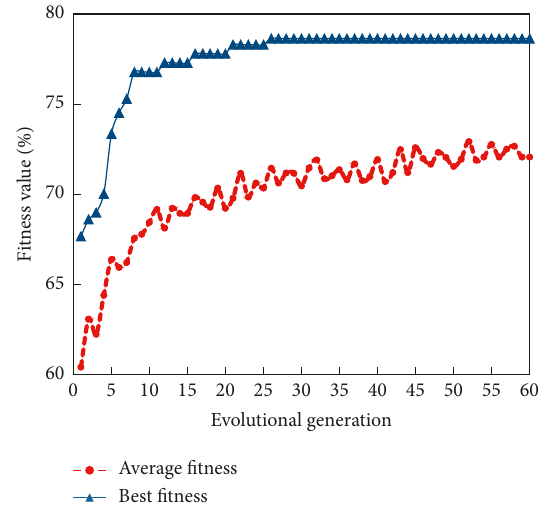
Figure 12: Variation curves of fitness values (BS density: 0–100/ km 2